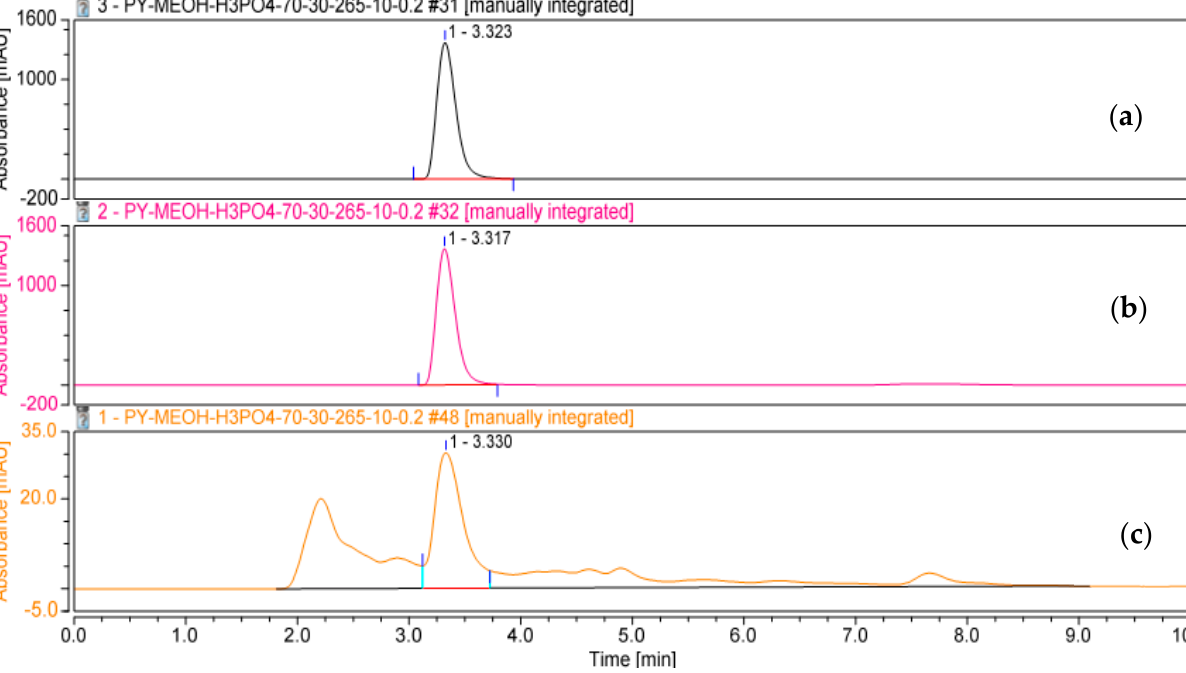
Figure 6. The GCMS profile of purified hemi ‐ pyocyanin produced by Pseudomonas aeruginosa TUN03.